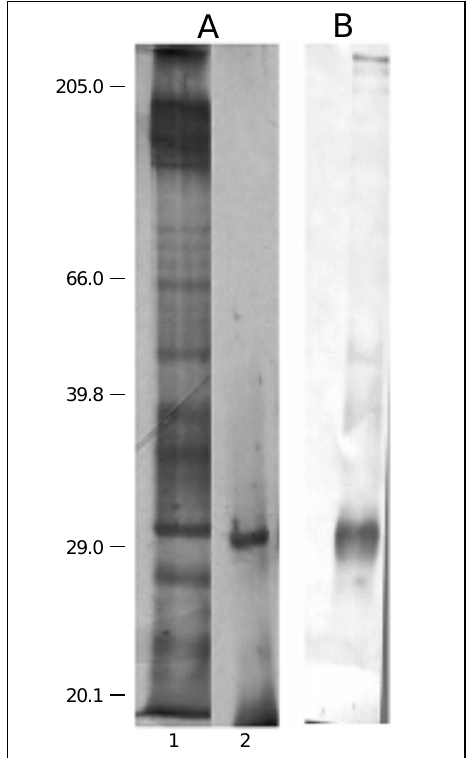
antibody against A. suum allergen